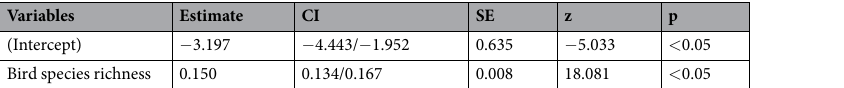
Table 1. Fixed-effect parameters in a Generalized Linear Mixed Model, accounting for cuckoo occurrence in relation to bird species richness (taxonomic diversity), in ten European and two Asian countries. The full model is based on 3592 sample sites. Random effects: Country (groups = 12) and dominant environment (groups = 5). CI: confidence interval (lower/upper); SE: standard